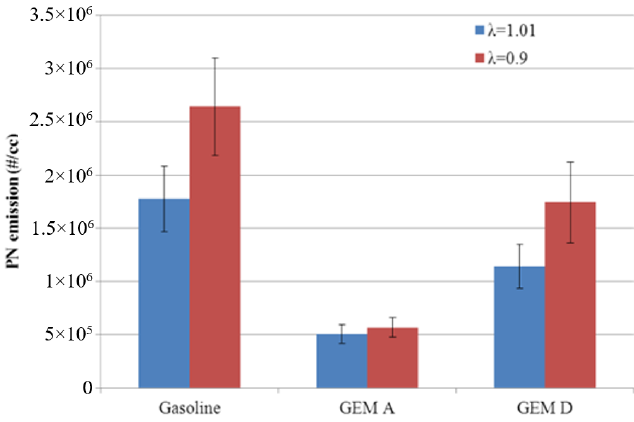
Figure 22. PN emissions from gasoline and two GEM fuels at 4.9 bar IMEP. Error bars correspond to ± σ .